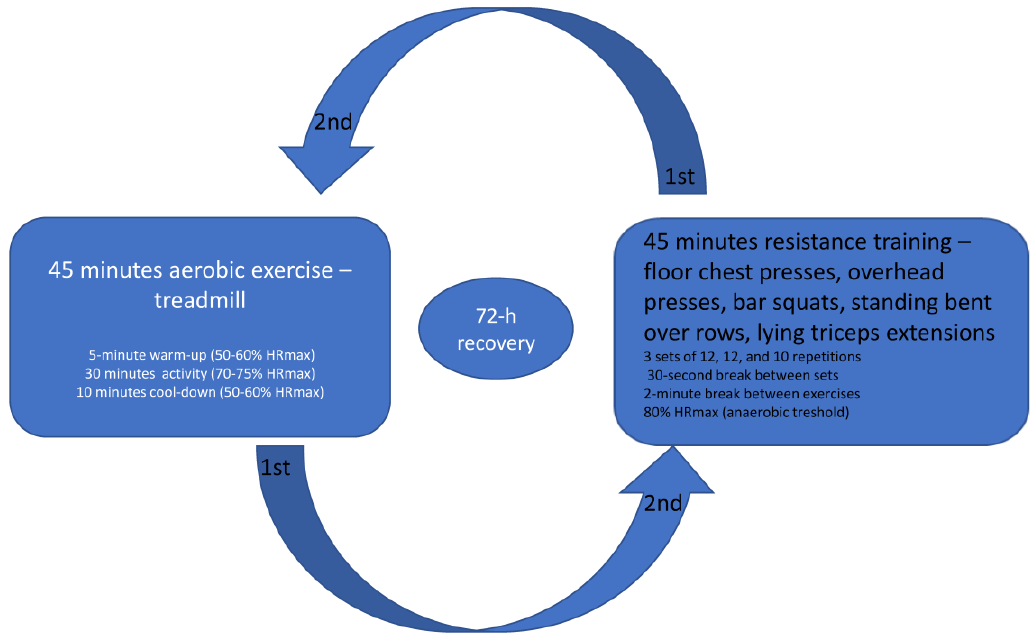
Figure 2. Aerobic and resistance training protocols were separated by 72 h recovery between the workout sessions.